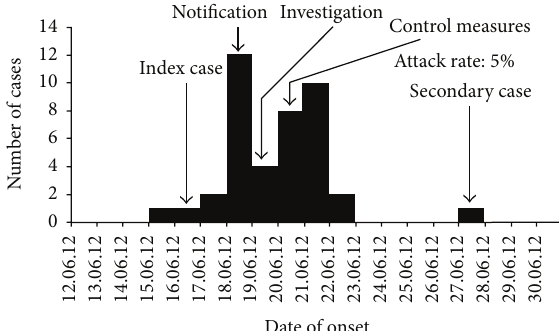
Figure 1: Epidemic curve of diarrhea outbreak at Haibatpur village, Purba Medinipur district, West Bengal, India, 2012.